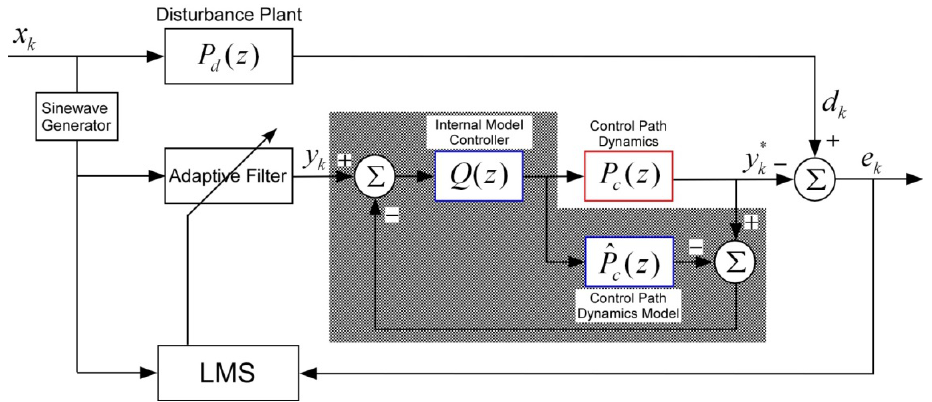
Figure 3. Schematic of a new digital filtering system with LMS, based on the internal model control (IM-LMS 1). The shaded region of Figure 3 indicates the IMC system for the secondary path dynamics P c .